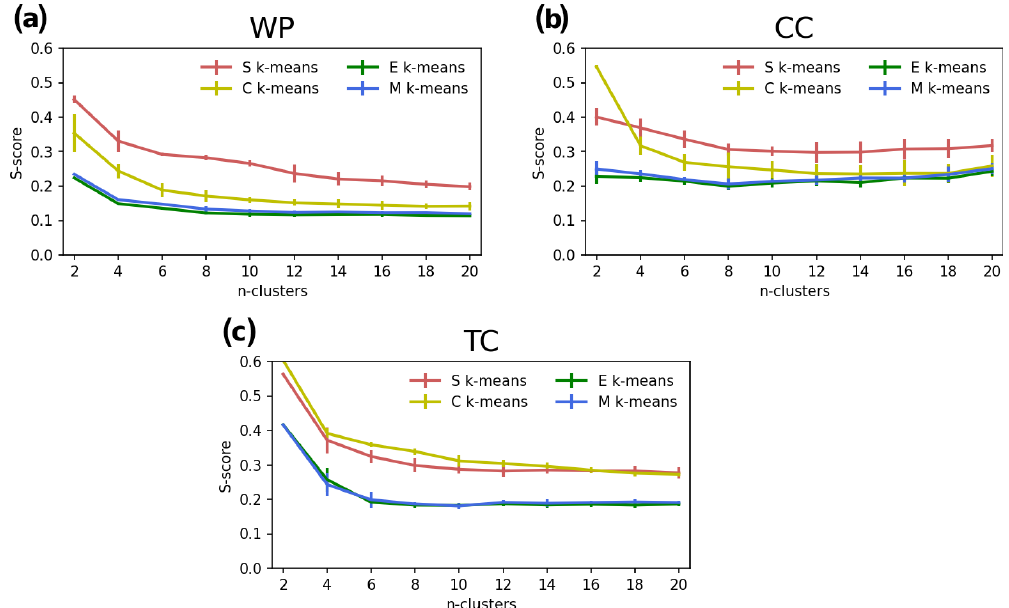
Figure 6. Comparison of the average silhouette score (S score) of S, C, E, and M k -means for k = 2, 4, ..., 20 for three demonstration experiments: WP (a) , CC (b) , and TC (c) . The uncertainty range in each line indicates the standard deviations of the scores among 10 runs with randomized